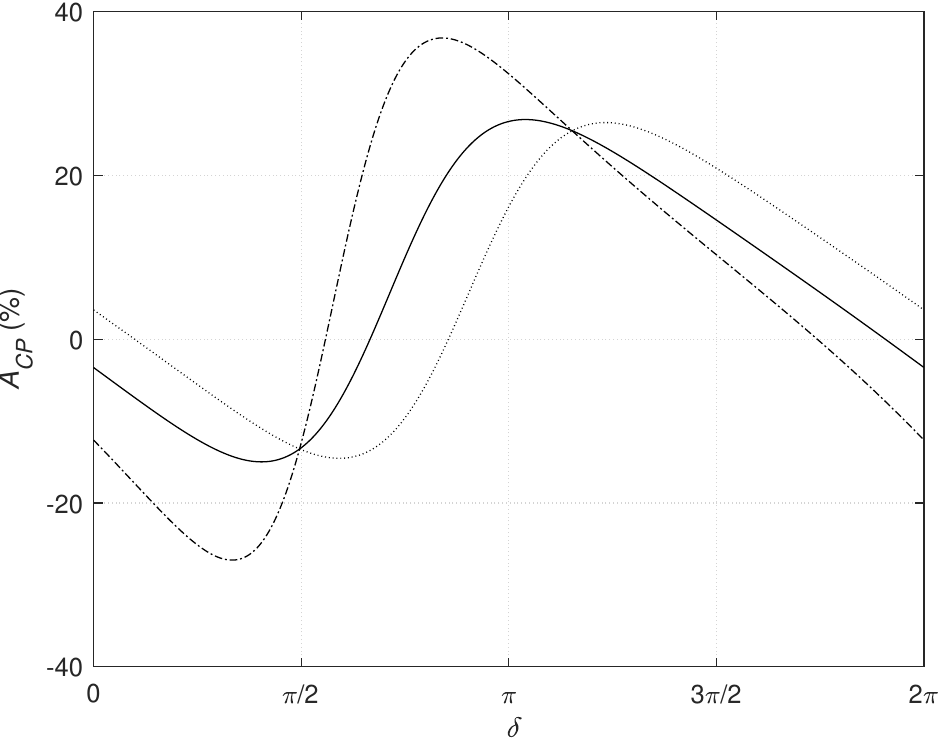
for Λ 0 → pπ − π + π − near the pπ − b pπ − ) , ∆